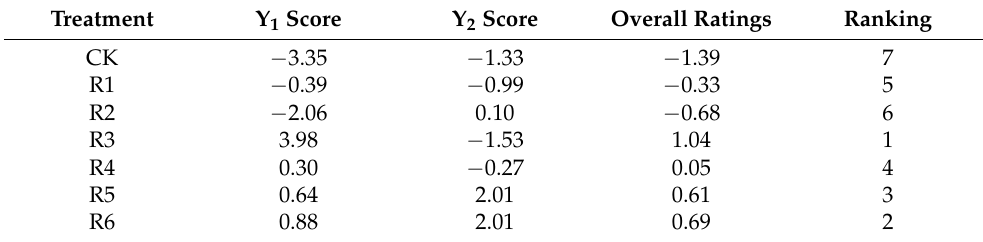
Table 9. Principal component scores and comprehensive scores of D. intortum inoculated with